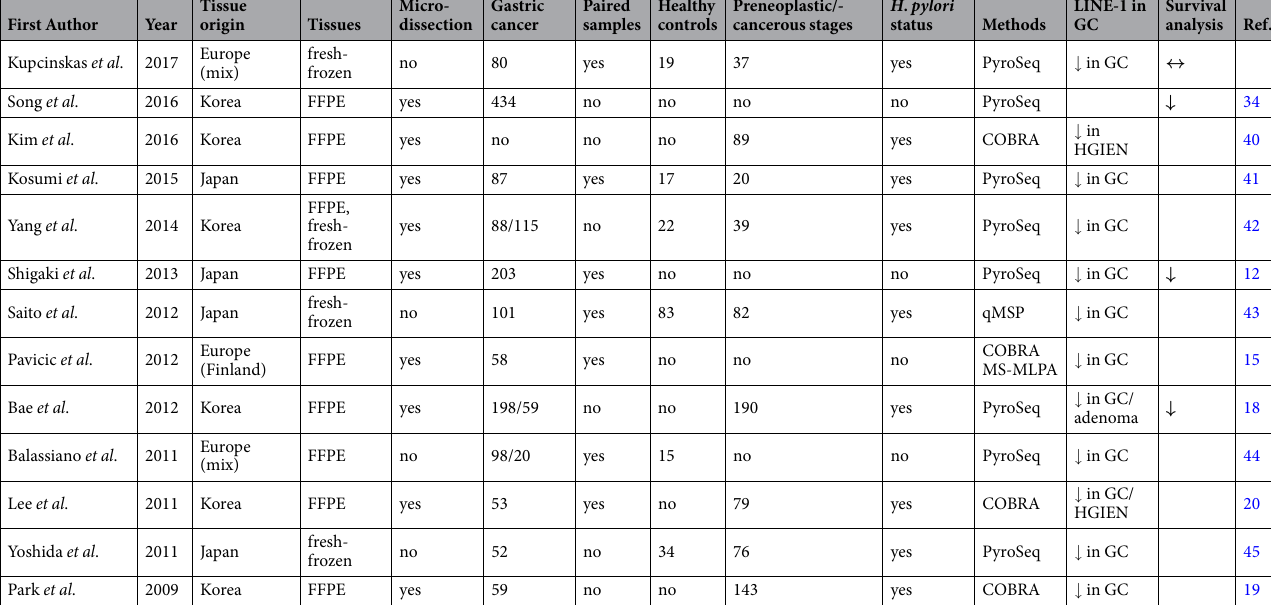
Table 2. Summary of the studies related to LINE-1 methylation in gastric cancer patients. qMSP: quantitative MSP (real-time); NA: non-available; FFPE: formalin-fixed paraffin-embedded tissue; PyroSeq: